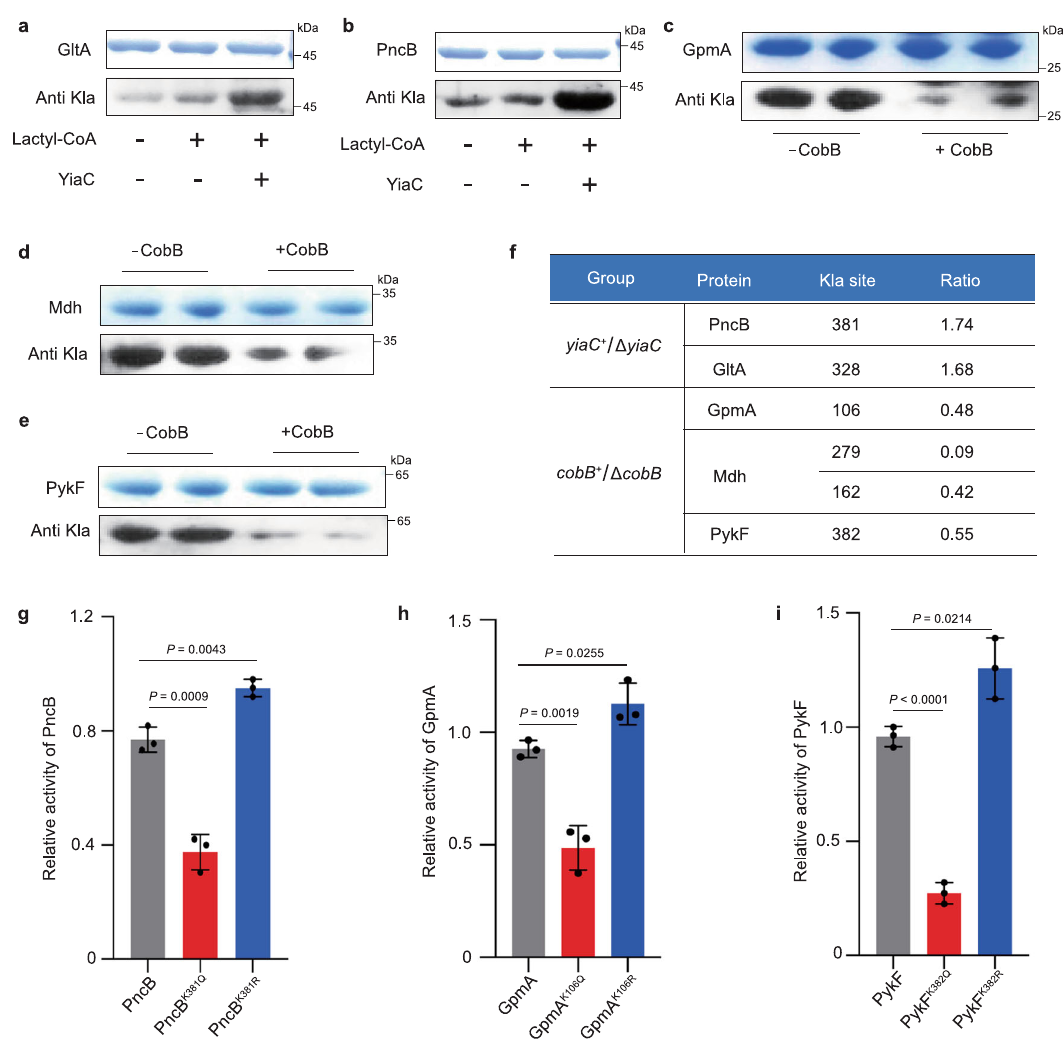
Fig. 5 | YiaC and CobB regulation Kla of multiple enzymes and in fl uence enzymatic activities in vitro. a , b YiaC can speci fi cally catalyze Kla of GltA and PncBinvitro.RecombinantGltAorPncBwasincubatedwithYiaCinthepresenceof lactyl-CoA(1mM) for 10h at25°C, and immunoblotting wasperformed. c – e CobB can speci fi cally erase Kla of GpmA, Mdh, and PykF in vitro. Recombinant GpmA, Mdh, or PykF was incubated with CobB for 10h at 25°C, and immunoblotting was